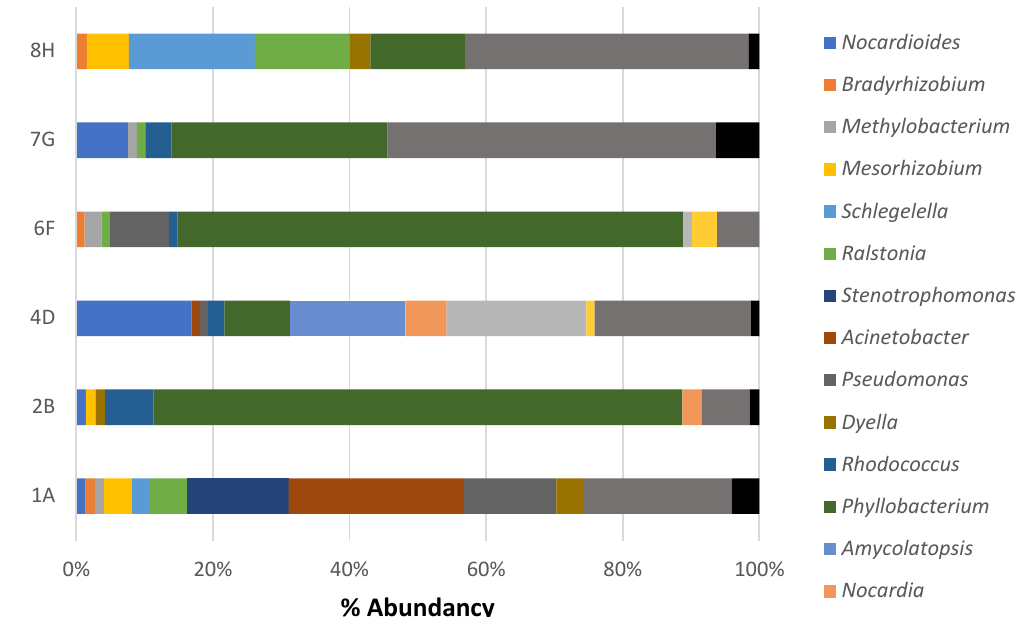
Figure 4. Distribution of bacterial genera retrieved from samples 1A (mill ceramic suspension), 2B (talc 1), 4D (clay), 6F (barium carbonate), 7G (talc 3) and 8H (tank ceramic slip).